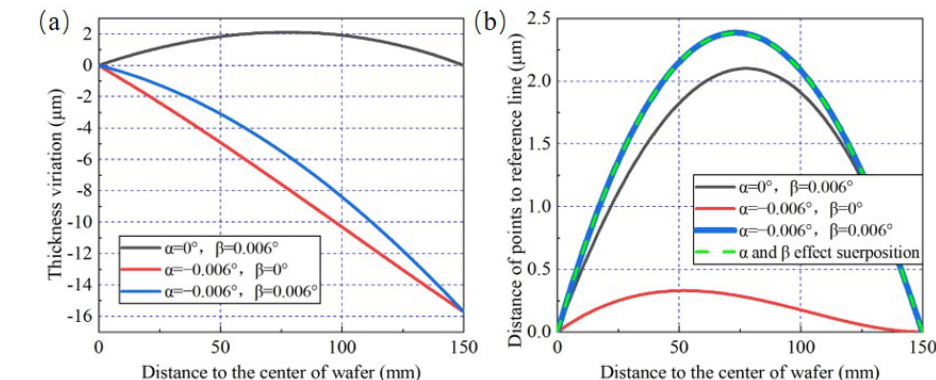
Figure 9. The verification to the superposition characteristics of δ 2 , under the combination of α and β (when β > 0). ( a ) Thickness variation simulation results. ( b ) The calculation results of the distance of points to the reference line.